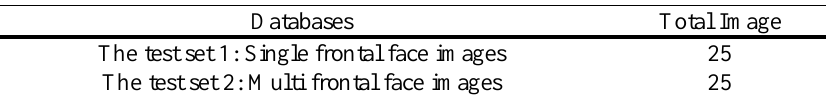
Table 3. Consider the data set.